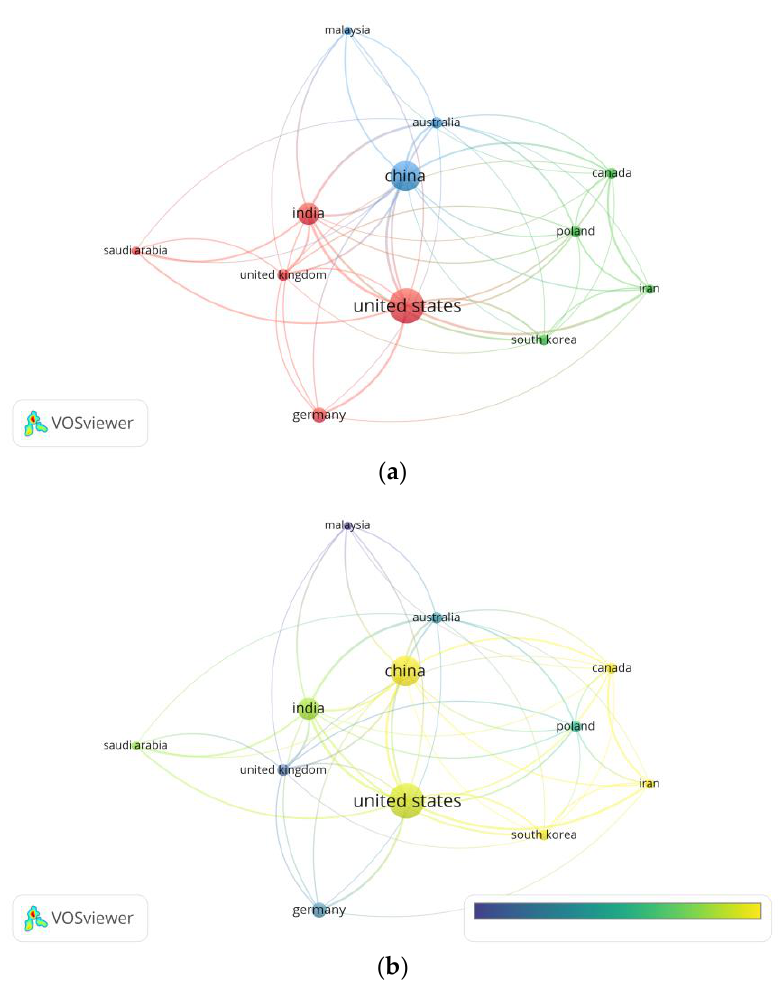
Figure 3. ( a ) Network visualization of co-authorship countries (weights: documents). ( b ) Overlay visualization of co-authorship countries in 2019 – 2022 (weights: documents; scores: average publications per year).